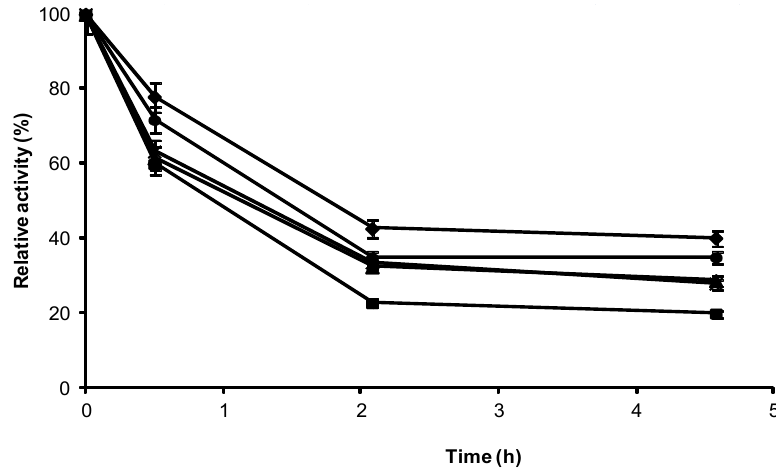
Figure 3. Stabilization of CRL in the presence of different additives. The additives were added at 20% ( w / v ) concentration and the experiments were performed at pH 10 and 4 °C. Without additive (squares), PEG (rhombus), glycerol (circles), dextran (triangles), threalose (×).